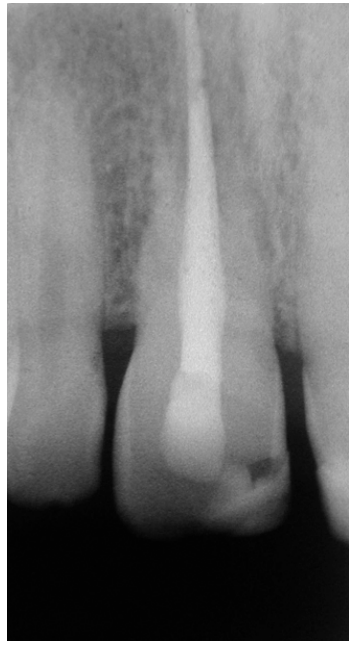
Figure 6. Rx at the 2-year recall visit.